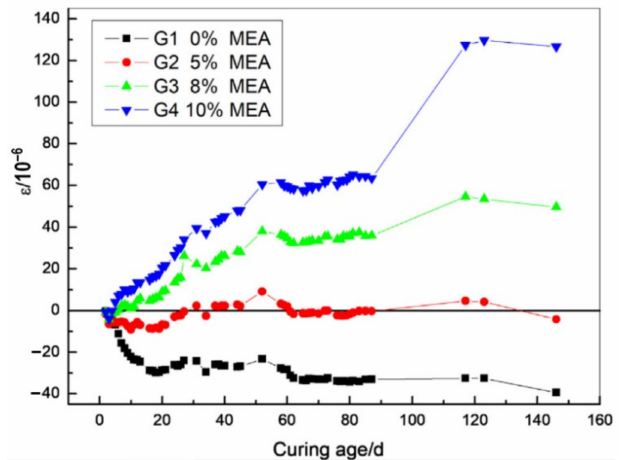
Figure 4. The influence of MgO content on the autogenous deformation of concrete (reprinted with permission from Ref. [26], 2019,